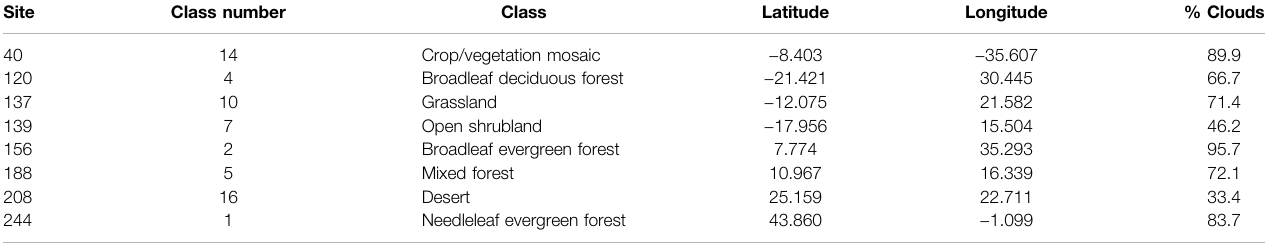
TABLE 7 | Characteristics of the eight sites selected for visualization purposes.